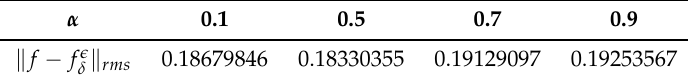
Table 4. Error norms, (cid:101) = 0.025 and η = 5.